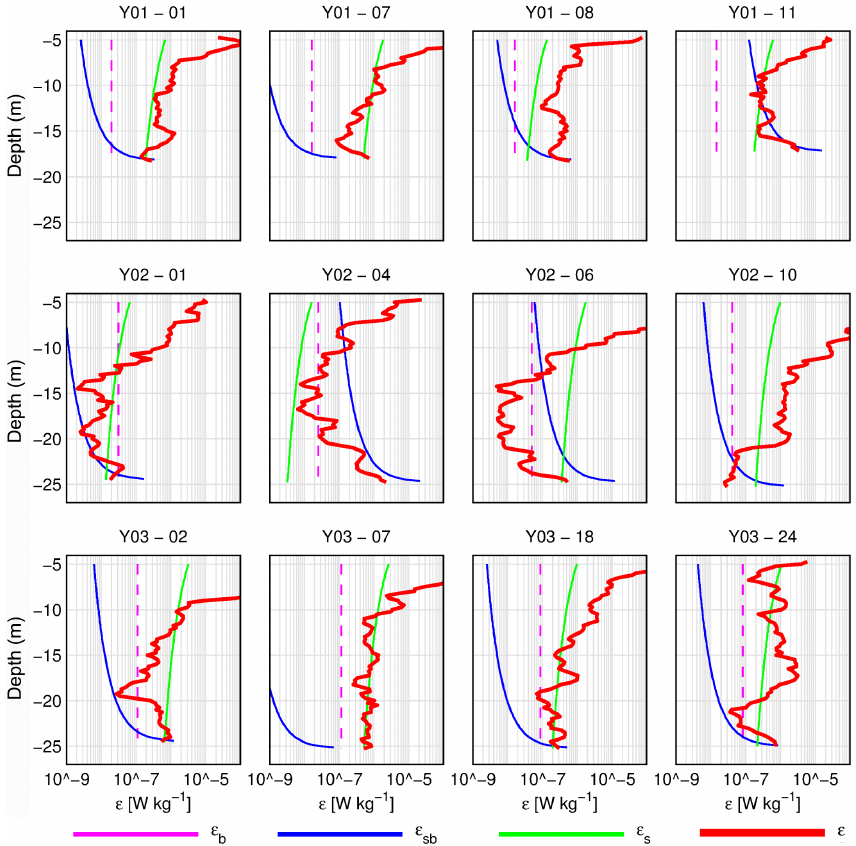
Figure 8. Similarity scaling of turbulent kinetic energy dissipation rate ( ε) for four representative casts for each yoyo, Y01 top panels, Y02 central panels and Y03 bottom panels. For each cast the observed TKE dissipation rate is shown ( ε , thick red line), and the turbulence generated by surface wind stress ( ε s , green line), bottom shear stress ( ε sb , blue line) and buoyancy flux ( ε b , magenta vertical dashed